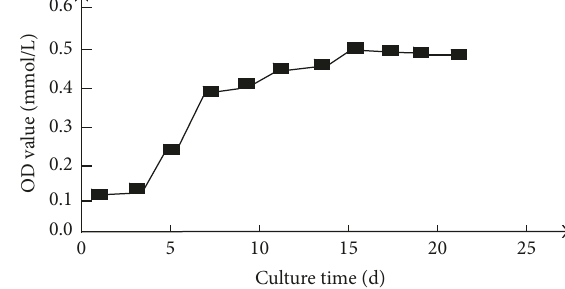
(b) GrowthcurveofmicroencapsulatedSGC9701cellsbyMTTassays. The proliferation rate of viable cells increased rapidly over 7–14